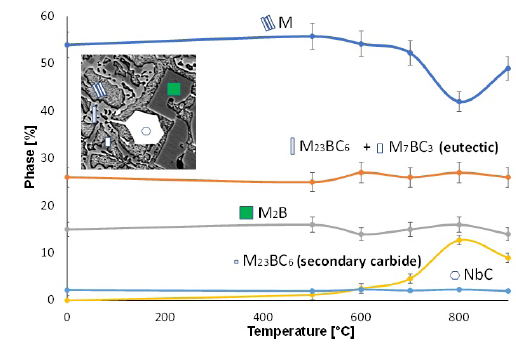
Figure 7. Percentage of phases based on PWHT temperature.